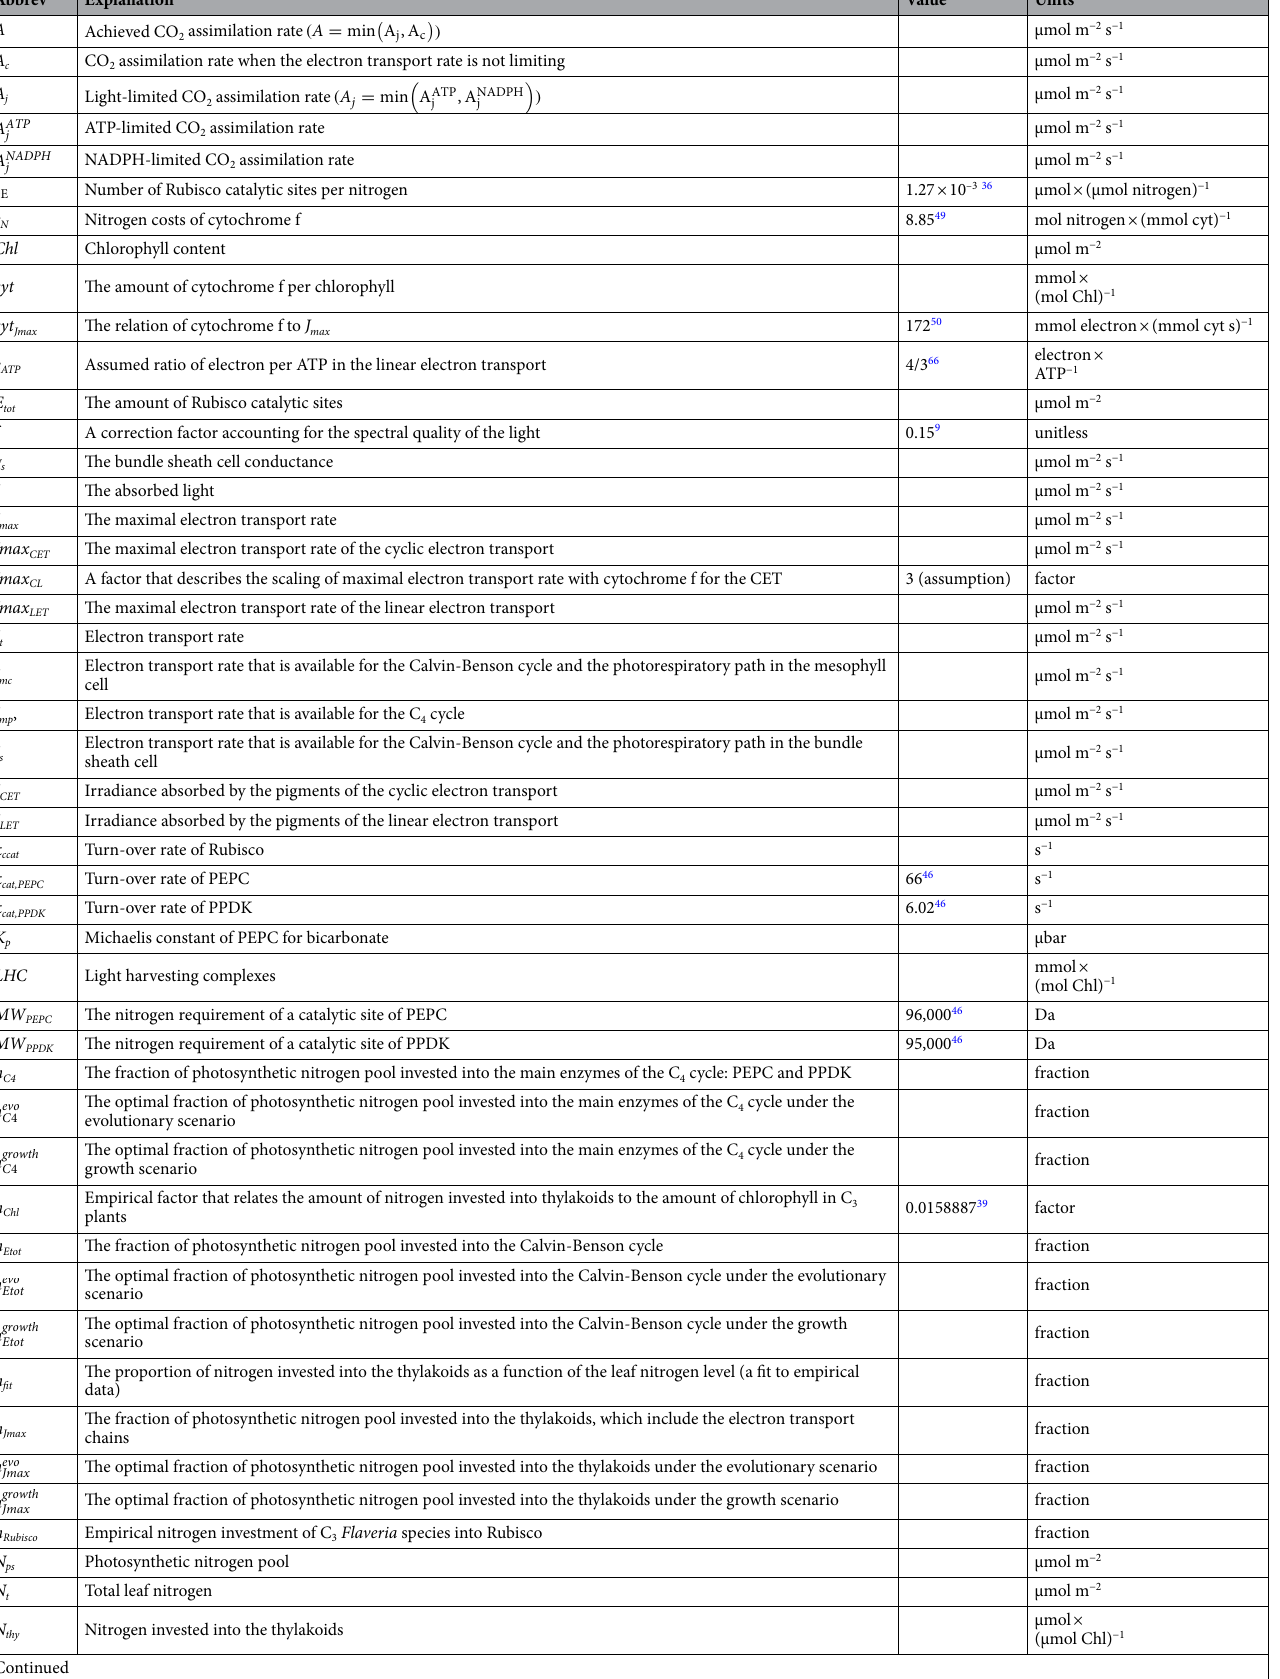
The fraction of photosynthetic nitrogen pool invested into the main enzymes of the C 4 cycle: PEPC and PPDK n evo C 4 The optimal fraction of photosynthetic nitrogen pool invested into the main enzymes of the C 4 cycle under the evolutionary scenario The optimal fraction of photosynthetic nitrogen pool invested into the main enzymes of the C 4 cycle under the growth scenario n Chl Empirical factor that relates the amount of nitrogen invested into thylakoids to the amount of chlorophyll in C 3 plants The fraction of photosynthetic nitrogen pool invested into the Calvin-Benson cycle The optimal fraction of photosynthetic nitrogen pool invested into the Calvin-Benson cycle under the evolutionary scenario The optimal fraction of photosynthetic nitrogen pool invested into the Calvin-Benson cycle under the growth scenario n fit The proportion of nitrogen invested into the thylakoids as a function of the leaf nitrogen level (a fit to empirical data) fraction n Jmax The fraction of photosynthetic nitrogen pool invested into the thylakoids, which include the electron transport chains fraction n evo Jmax The optimal fraction of photosynthetic nitrogen pool invested into the thylakoids under the evolutionary scenario The optimal fraction of photosynthetic nitrogen pool invested into the thylakoids under the growth